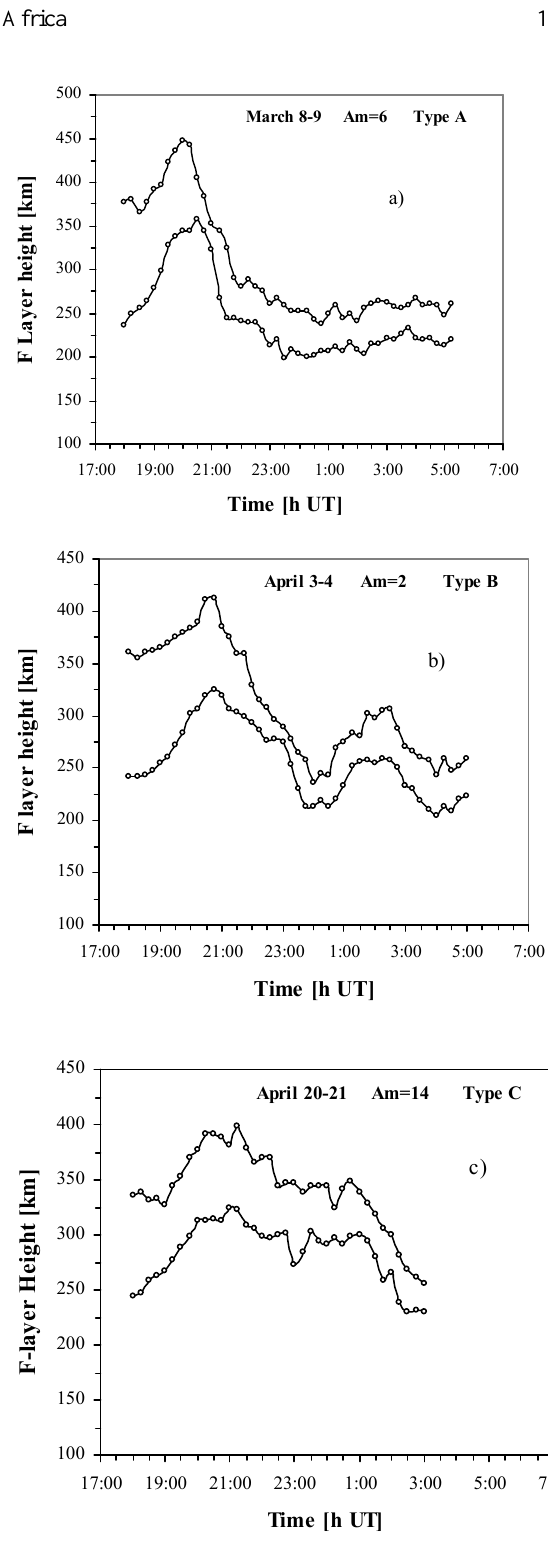
Fig. 2. Typical height variations in kilometers at Korhogo as a function of UT time, (a) the usual type A for the classical single post-sunset rise, (b) the truly equatorial type B showing post-sunset type A plus one or two meridional wind-induced height peaks, (c) the abnormally wide single peak C centred near